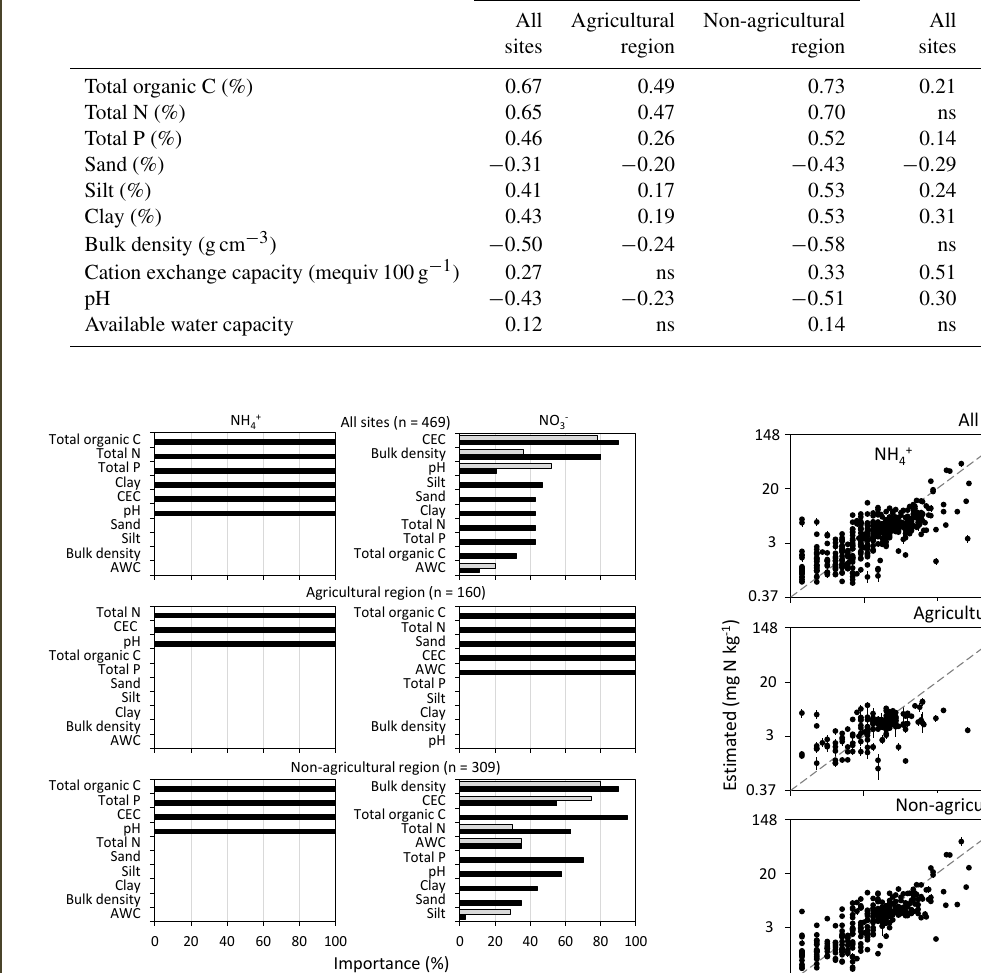
+ 4 + and NO − contents on the log-transformed Figure 4. Soil NH 4 3 scale estimated by optimized Cubist models. Points represent model evaluation by 10-fold, 50-repeated cross-validation. The error bar is the standard deviation of the estimated mineral N content. The 1:1 line is